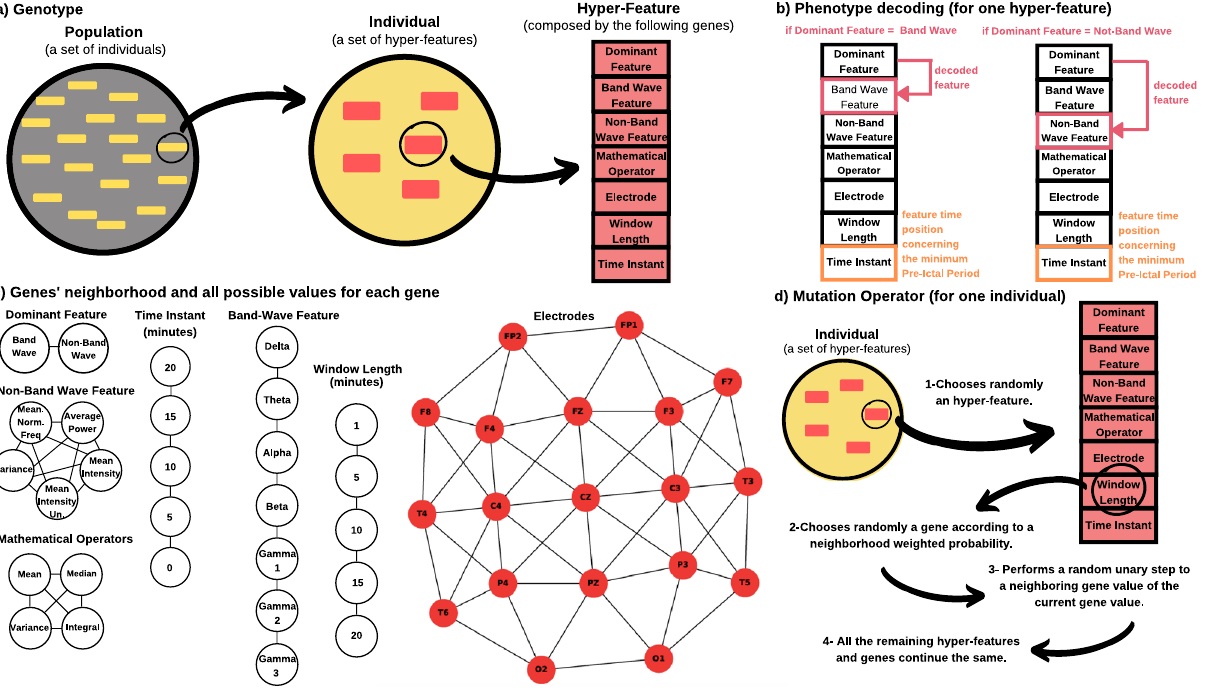
Figure 3. An illustrated scheme of genotype ( a ), phenotype decoding ( b ), gene’s neighbourhood and all possible values for each gene ( c ), and the mutation operator functioning ( d